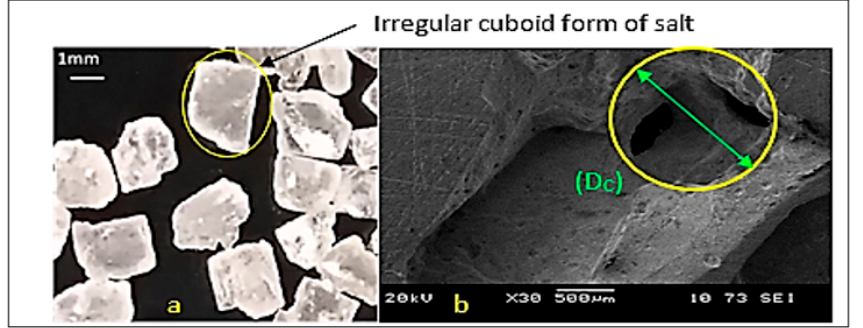
Figure 9. ( a ) Photography of the salt used in the ESR process: the particle had an irregular cuboid form. ( b ) SEI image magnification by JOEL JSM-6360 of cuboid cell shape replicas of the salt grain used and the interconnection windows of ESR foam from [12]. In this study, the nominal cell diameter (D C ) considered was the diameter of the internal sphere surrounding the cuboid cell and having the same salt grain circumscribing sphere diameter determined by sieving.